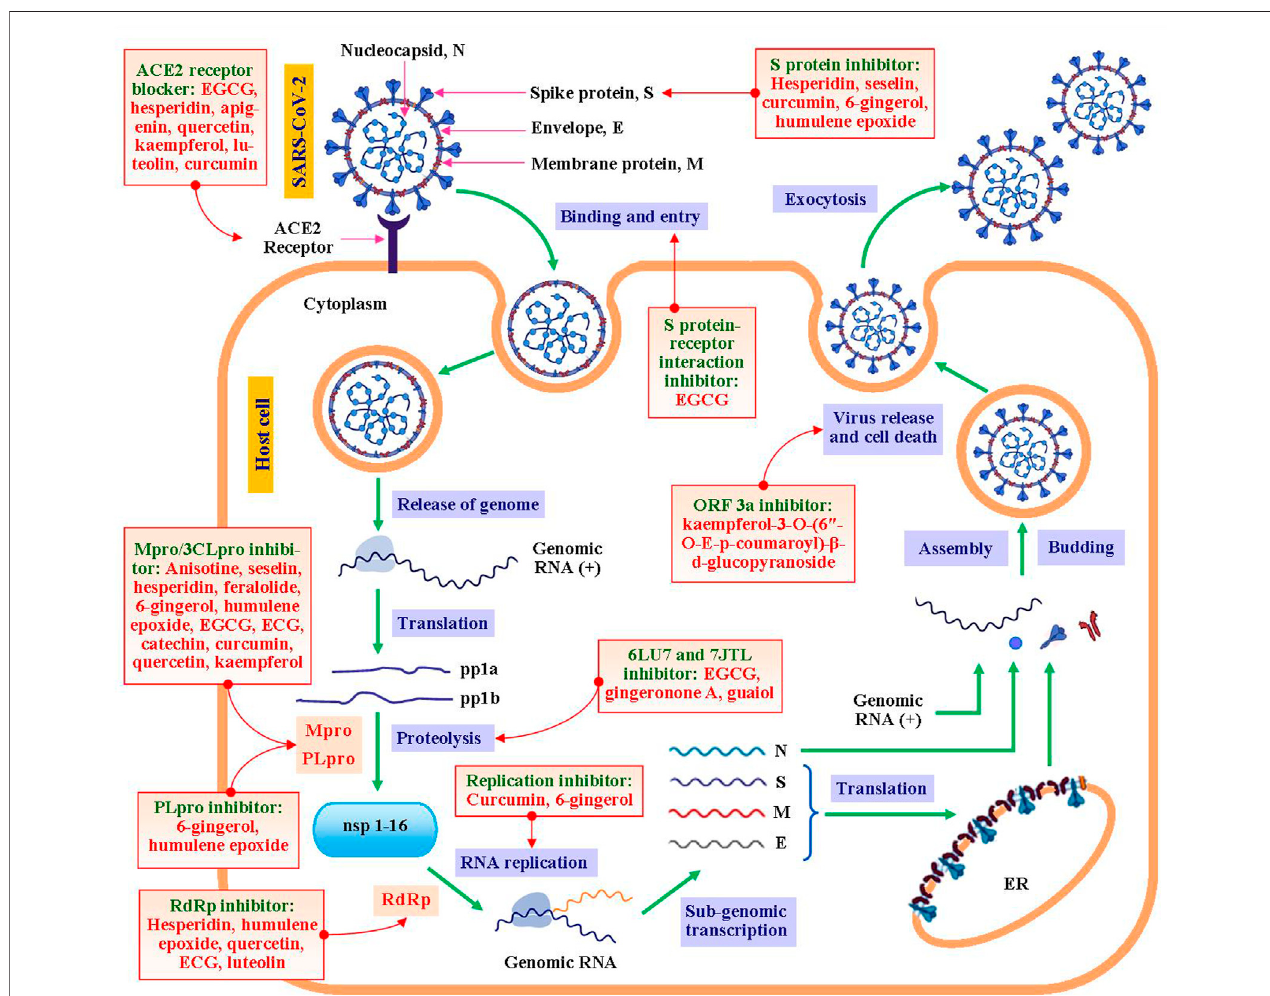
FIGURE 1 | Impact of bioactive metabolites derived from Bangladeshi medicinal plants on molecular targets of various steps of multiplication process of SARS- CoV-2. ACE2, angiotensin converting enzyme 2; N, Nucleocapsid; S, M, E:,spike, membrane, envelope proteins; pp1a, pp1b, nonfunctional polypeptides; nsp, nonstructural proteins; Mpro, main protease; 3CLpro, 3-chymotrypsin like protease; PLpro, papain like protease; RdRp, RNA dependent RNA polymerase; RNA (+), positive-sense RNA; and ER, endoplasmic reticulum.